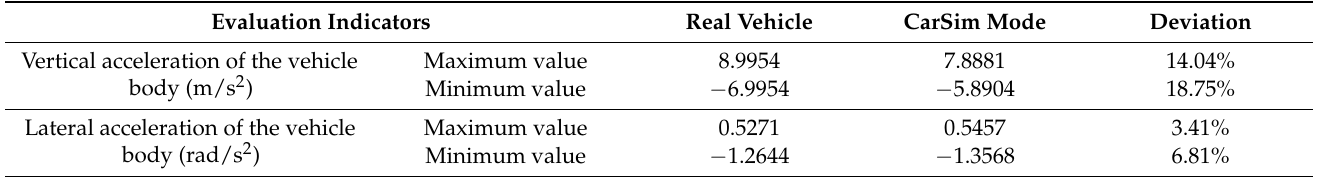
Table 7. Time domain response of the vehicle body passing over a trapezoidal speed bump